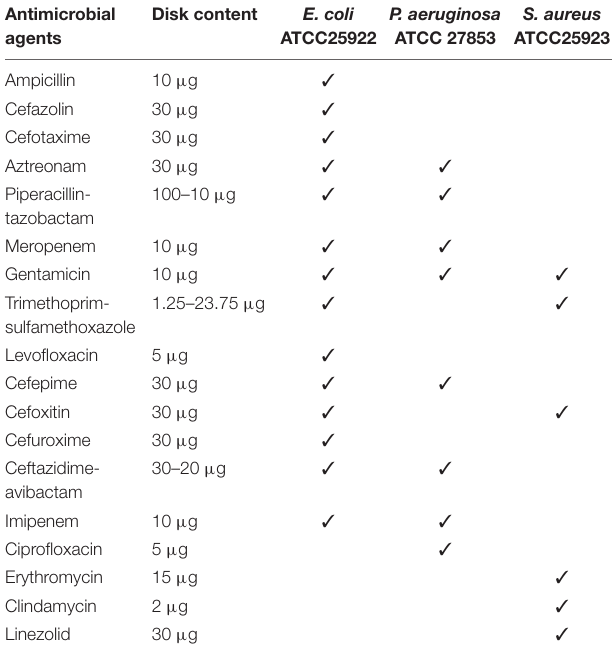
TABLE 1 | Antimicrobial agents included and their disk